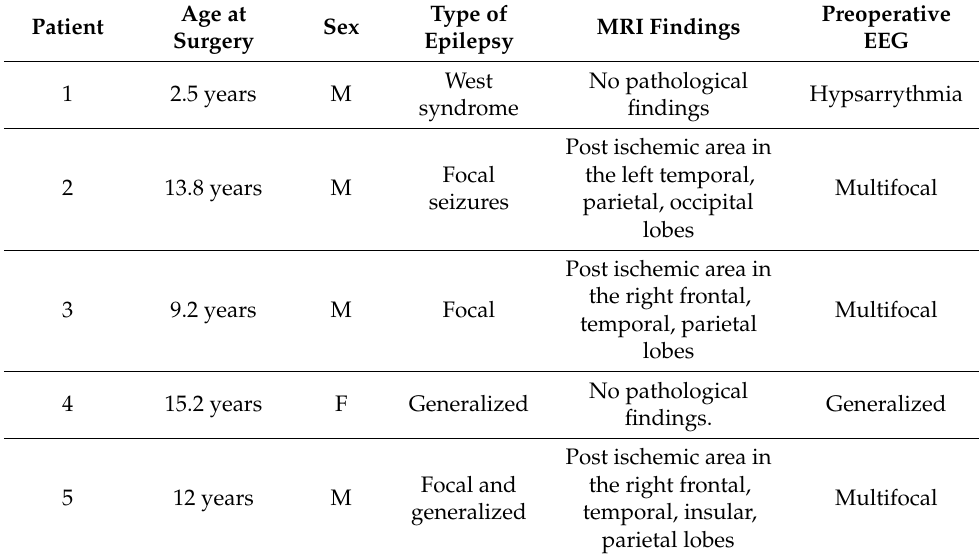
Table 1. Preoperative characteristics of the patients.